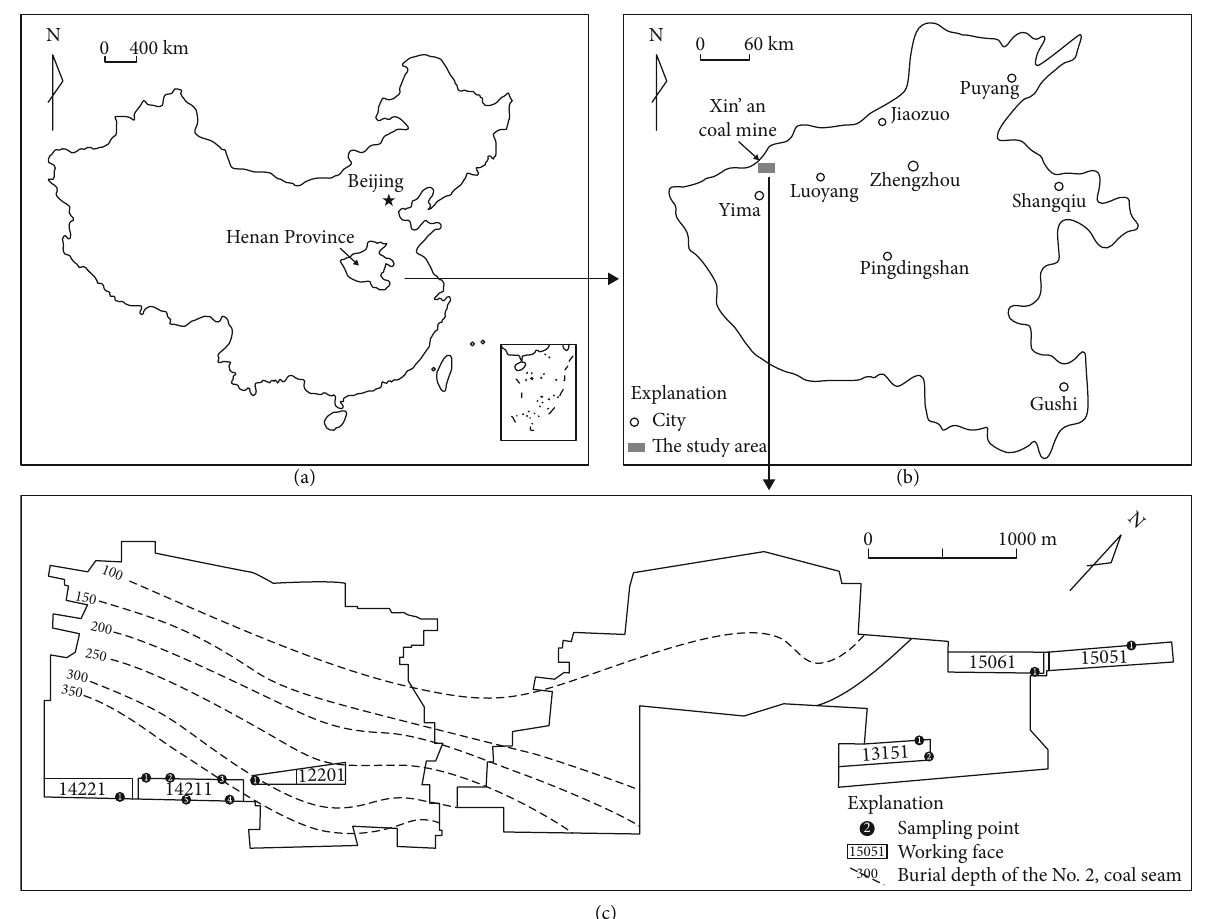
Figure 1: (a) Location of the Henan Province. (b) Location of the Xin ’ an coal mine. (c) Map showing sampling points, working faces, and burial depth of the No. 2 coal in mining area of the Xin ’ an coal mine. 1 Table 1: Summarized results of petrographic analysis, proximate analysis, pore structure parameters, and Langmuir constants of the No. 2 coal in the Xin ’ an coal